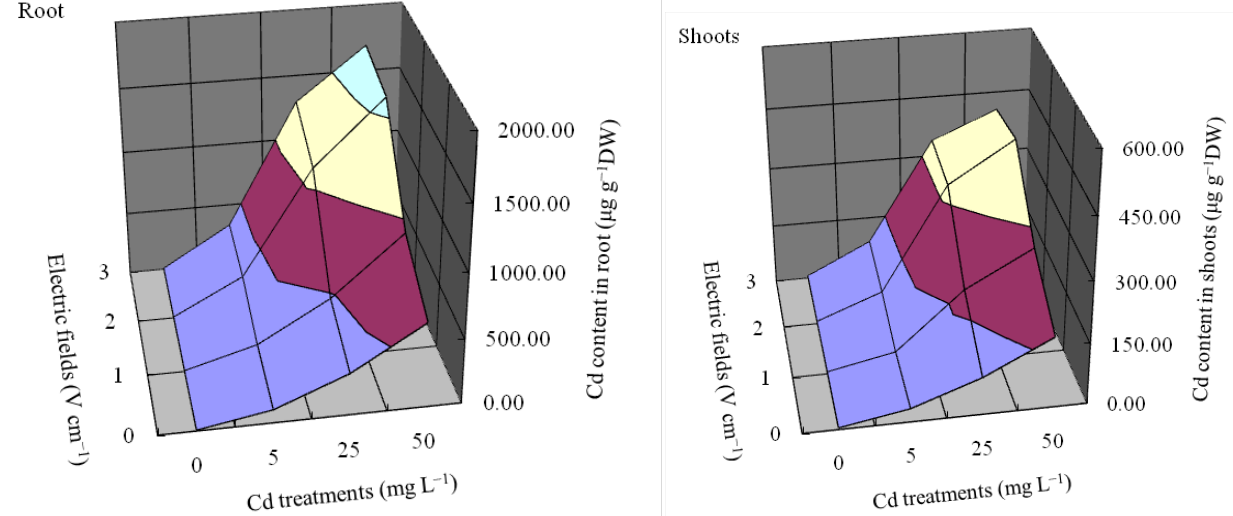
Figure 2. The relationship of different treatments and Cd contents in roots and shoots of L. japonica . Values represent the mean.